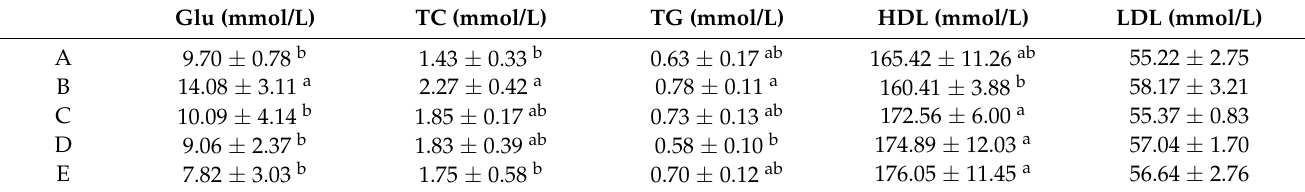
Table 2. Effects of different GSP groups on blood glucose, TC, TG, HDL, and LDL levels in the blood of rats.